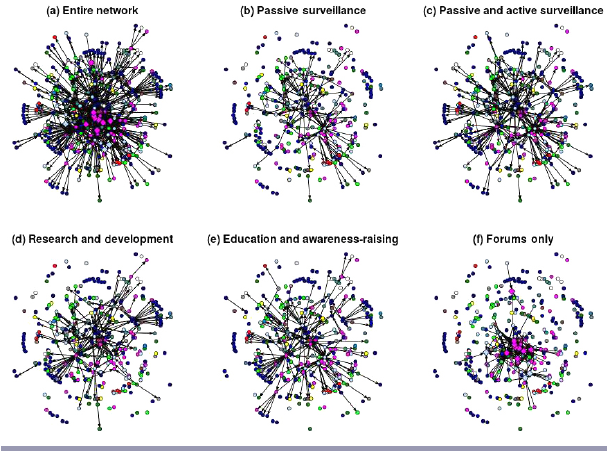
Fig. 2 . Networks explored (a) to (f) using exponential random graph models. Squares represent policy forums, circles represent organizations in marine pest network. Ties represent information sharing (one-mode) or affiliations through forums